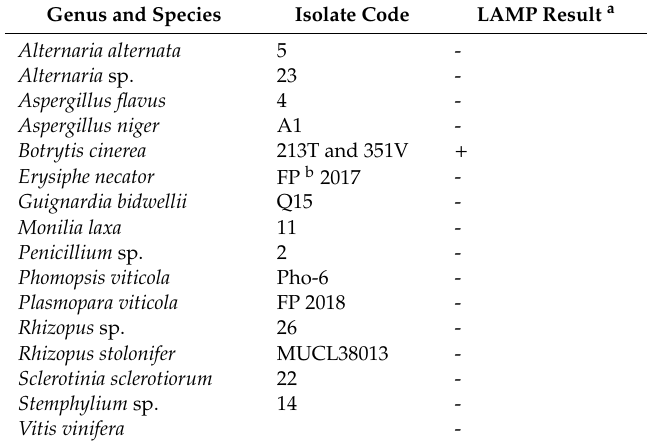
a + indicates amplified, and - indicates not amplified. b FP: field population and year of collection.